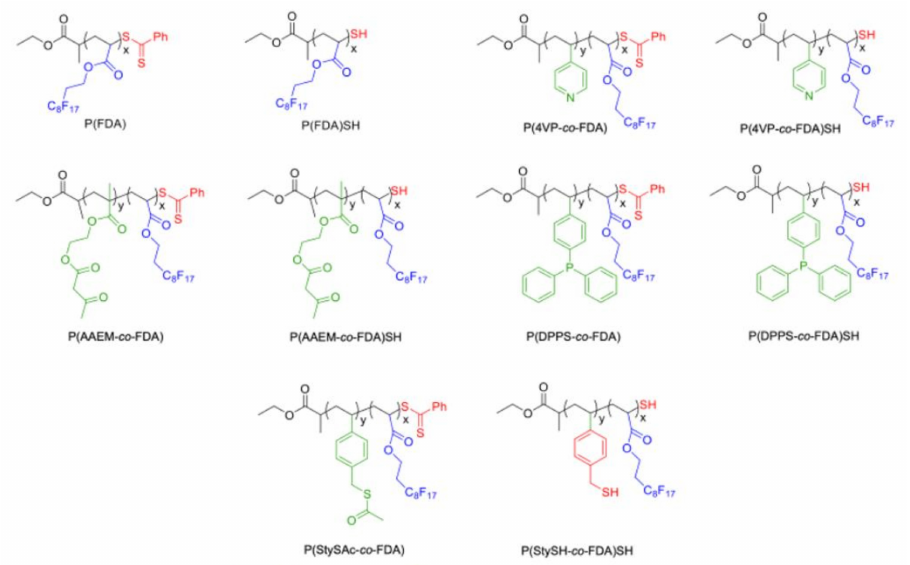
Figure 1. Synthesized CO 2 -soluble fluorinated homopolymers and copolymers bearing metal- complexing groups (acetoacetoxy, triphenylphosphine, pyridine, thioacetate,